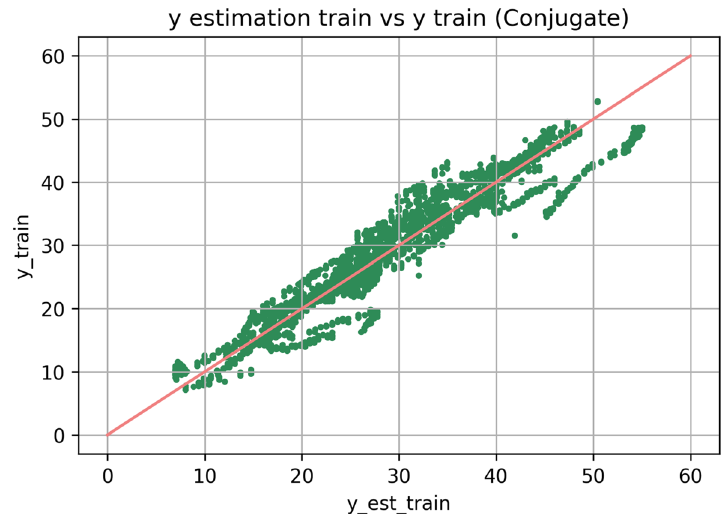
Fig. 10 y estimation train vs y train